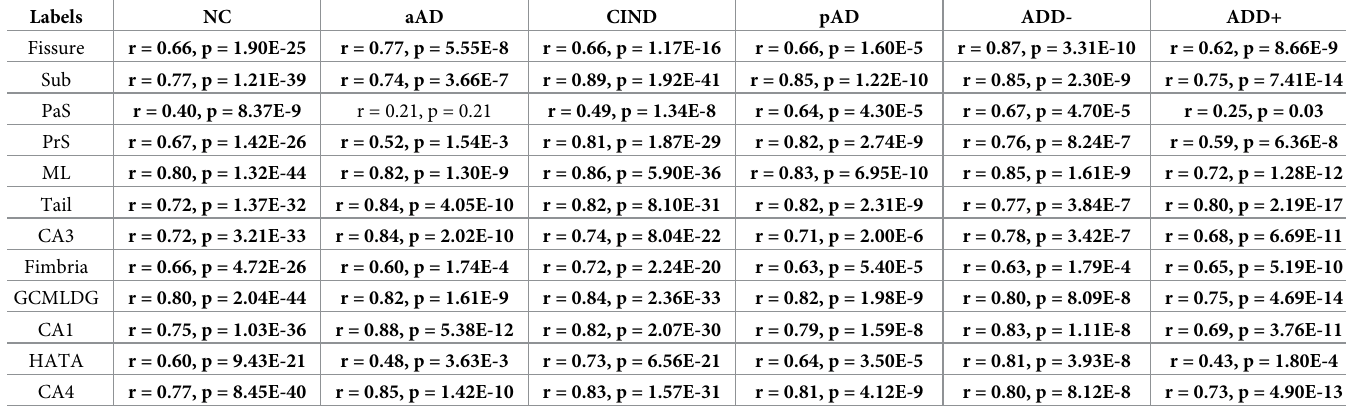
Table 5. Correlations between the two